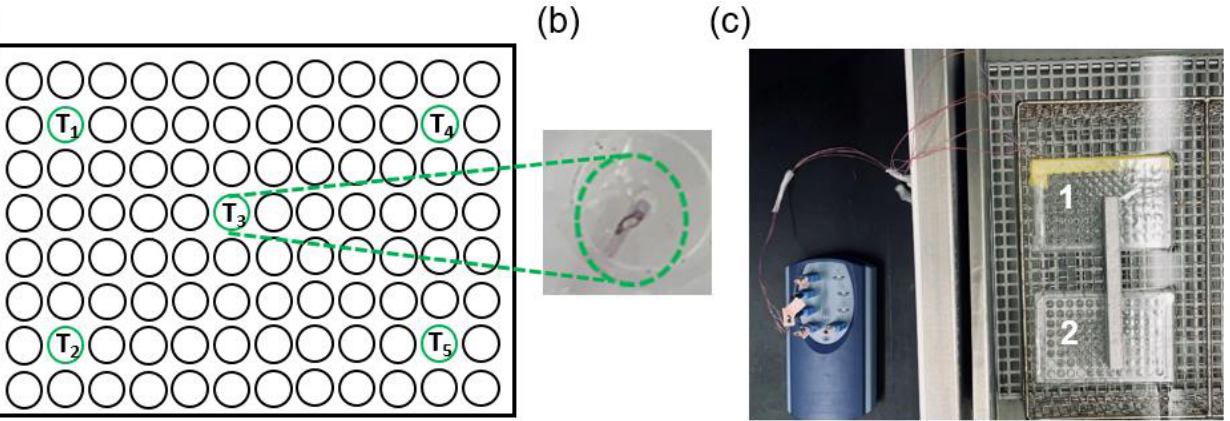
Figure 1. ( a ) Dummy plate design with five thermocouples for monitoring temperature during hyperthermia sealed within four corner wells and one central well. ( b ) Photograph of a thermocouple sealed within a well. ( c ) Cell-containing plate (plate 2) and dummy plate (plate 1) immersed within the water bath during hyperthermia.